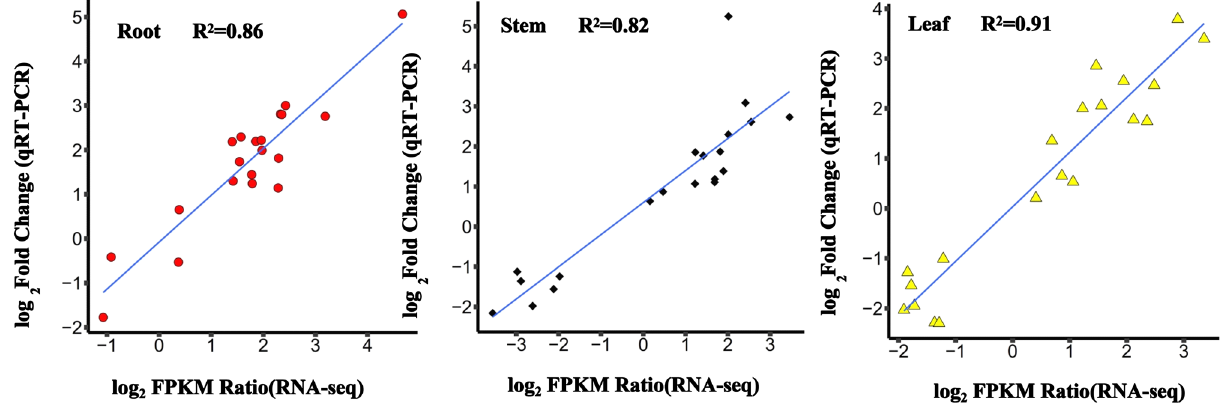
Figure 3. qRT-PCR validation of transcript levels evaluated by RNA-Seq in roots, stems and leaves under 300 mM Na 2 SO 4 stress conditions. X-axis represents log 2 FC (Fold Change) derived from RNA-seq; Y-axis represents log 2 (2 −ΔΔCt ) specifically from the qRT-PCR experiment. (A) Transcript level of roots. (B) Transcript level of stems. (C) Transcript level of